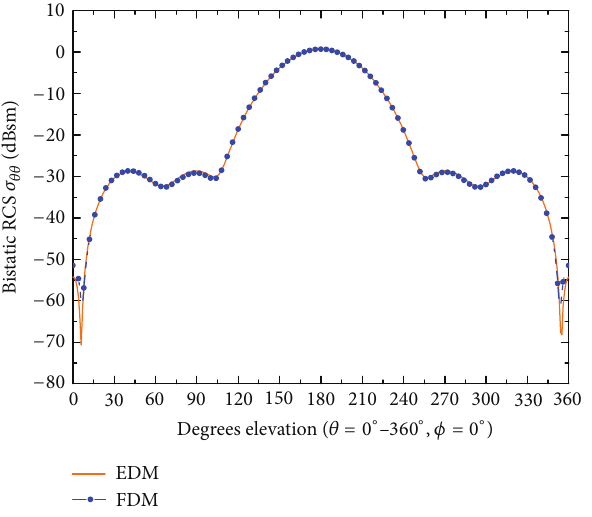
Figure3:BistaticRCSofaspherearraywith 𝜀 𝑟1 = −1 , 𝜇 𝑟1 = −1 , 𝜀 𝑟2 = = 1 , 𝜀 = −1 , 𝜇 = −1 , 𝜀 = 2 , and 𝜇 = 1 and performed 2 , 𝜇 𝑟2 𝑟3 𝑟3 𝑟4 𝑟4 at 0.6GHz excited by a plane wave with the incident direction of (𝜃, 𝜙) = (0 ∘ ,0 ∘ )